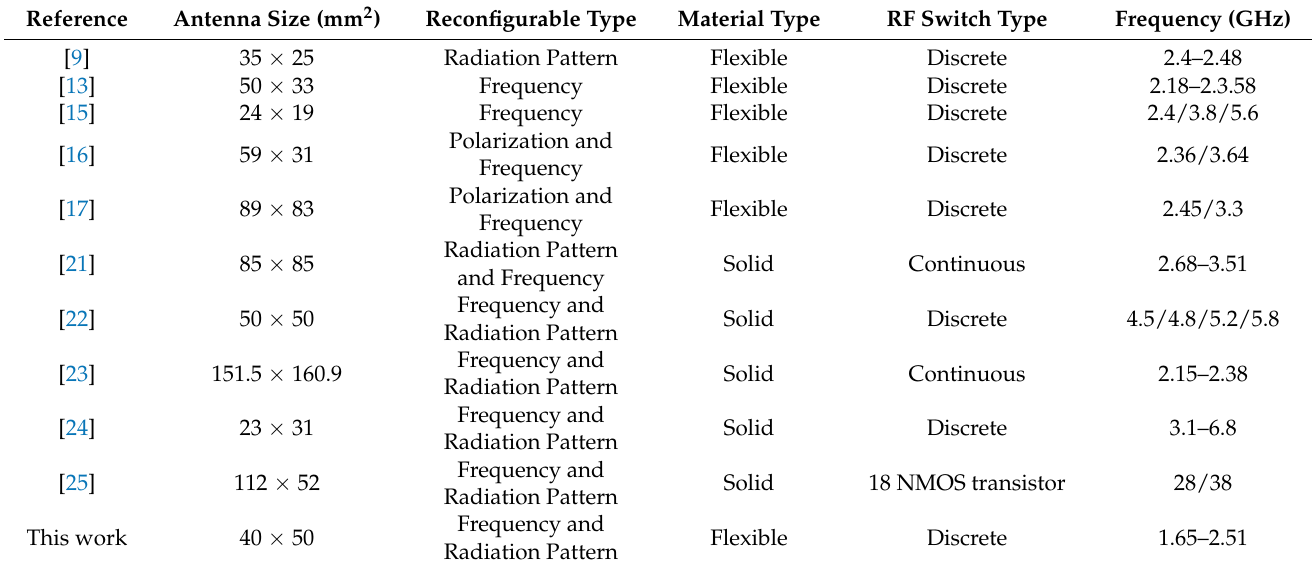
Table 1. Comparison of the proposed work with the state-of-the-art